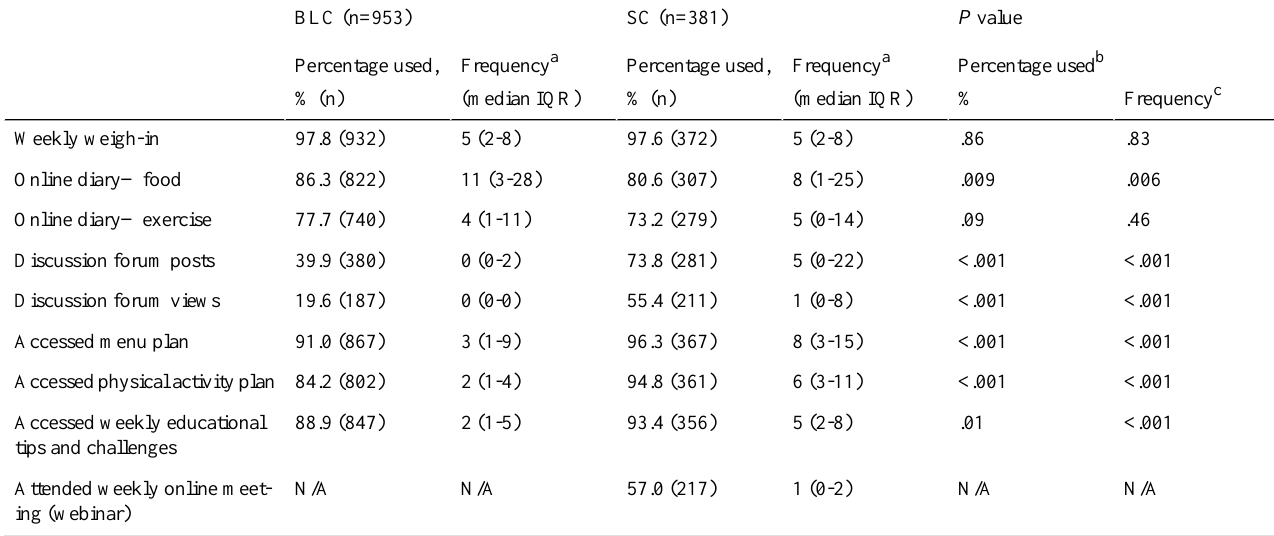
Table 4. Website use by BLC and SC participants from enrollment to 8